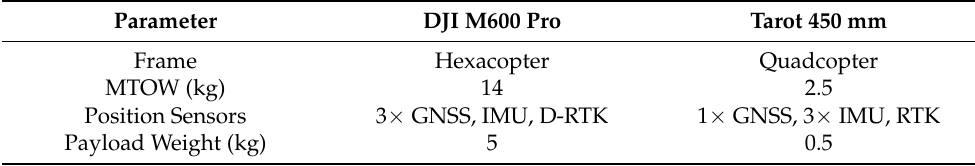
Figure 3. UAVs used for experimentation. ( a ) DJI Matrice M600. ( b ) Tarot X4. Table 1. Salient specifications of the UAV systems used for the flight